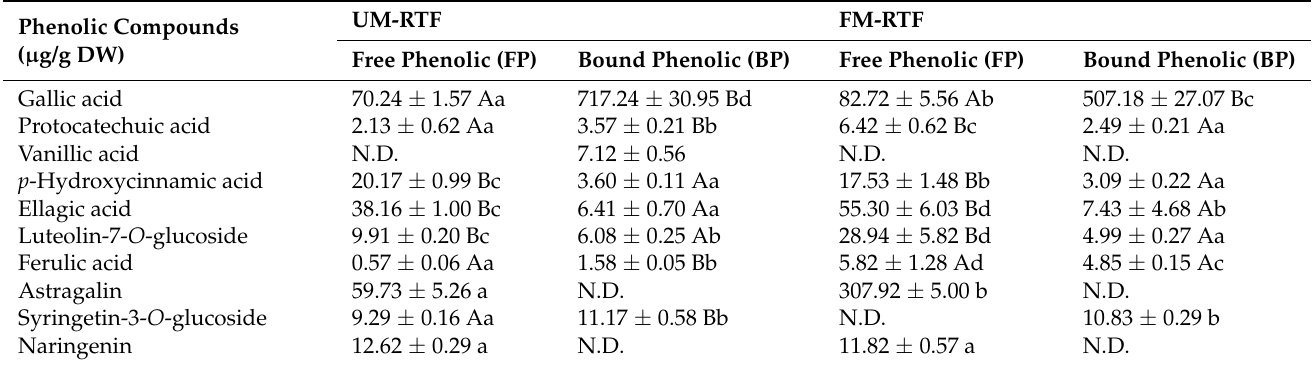
Table 3. The contents of individual phenolic compounds of RTF in two ripening